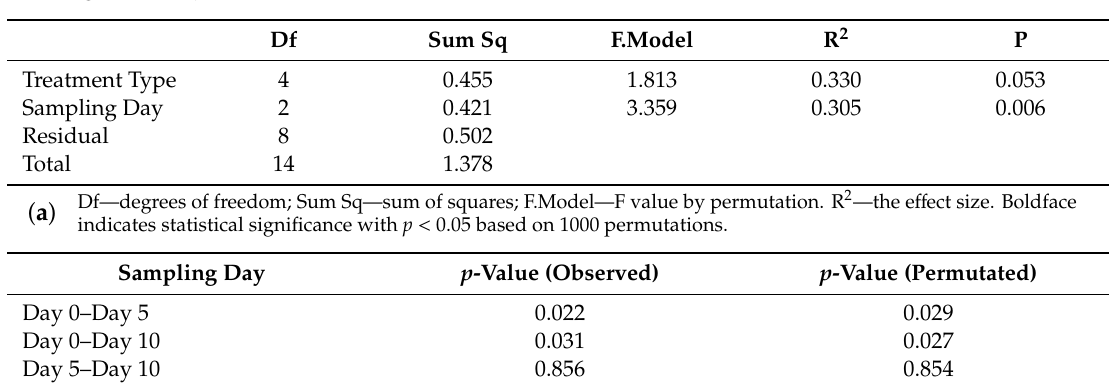
Table3. ( a )Permutationalmultivariateanalysisofvariance(PERMANOVA)resultsbasedonBray-Curtis dissimilarities using abundance data for treatment types and sampling days. ( b ) Analysis of variance (ANOVA) pairwise comparison tests of dispersion of microbial composition among sampling days (significant if p value < 0.05).